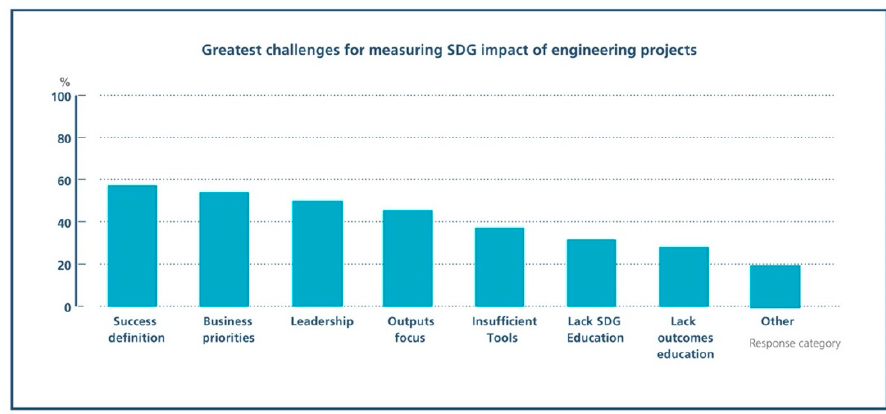
Figure 13. Responses to Question 6: What are the greatest challenges for measuring SDG impact? (See Appendix B for full data).